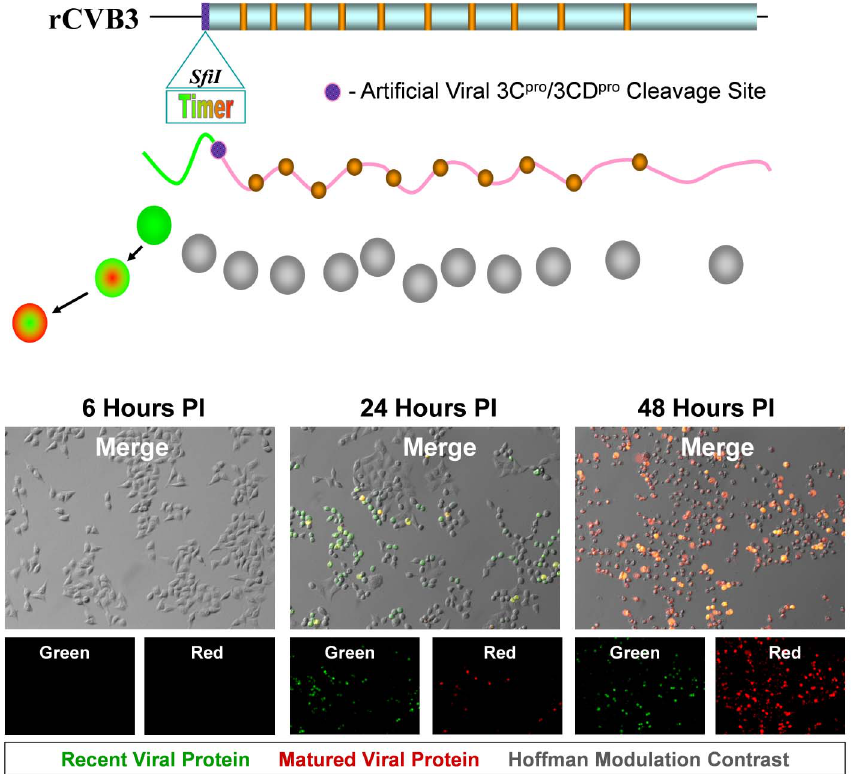
Figure 1. HeLa cells infected with Timer-CVB3 slowly change fluorescence from green to red. The gene for ‘‘fluorescent timer’’ protein was inserted into the infectious plasmid clone for CVB3 (pMKS1) which contains a unique Sfi 1 restriction site followed by the coding sequence for a polyglycine linker and a 3C pro /3CD pro cleavage site (shown as a purple circle) immediately downstream of the viral polyprotein start codon. Upon HeLa cell infection with recombinant CVB3 expressing ‘‘fluorescent timer’’ protein (Timer-CVB3), we expected the slow conversion of the green fluorescing form of timer protein to red (shown diagrammatically). HeLa cells infected with Timer-CVB3 (moi=0.1) initially fluoresced green (recent viral protein) at 24 hours PI as determined by fluorescence microscopy. By 48 hours PI, both green and red fluorescence (matured viral protein) was observed in infected HeLa cells, although the majority of cells fluoresced brightly in the red channel.